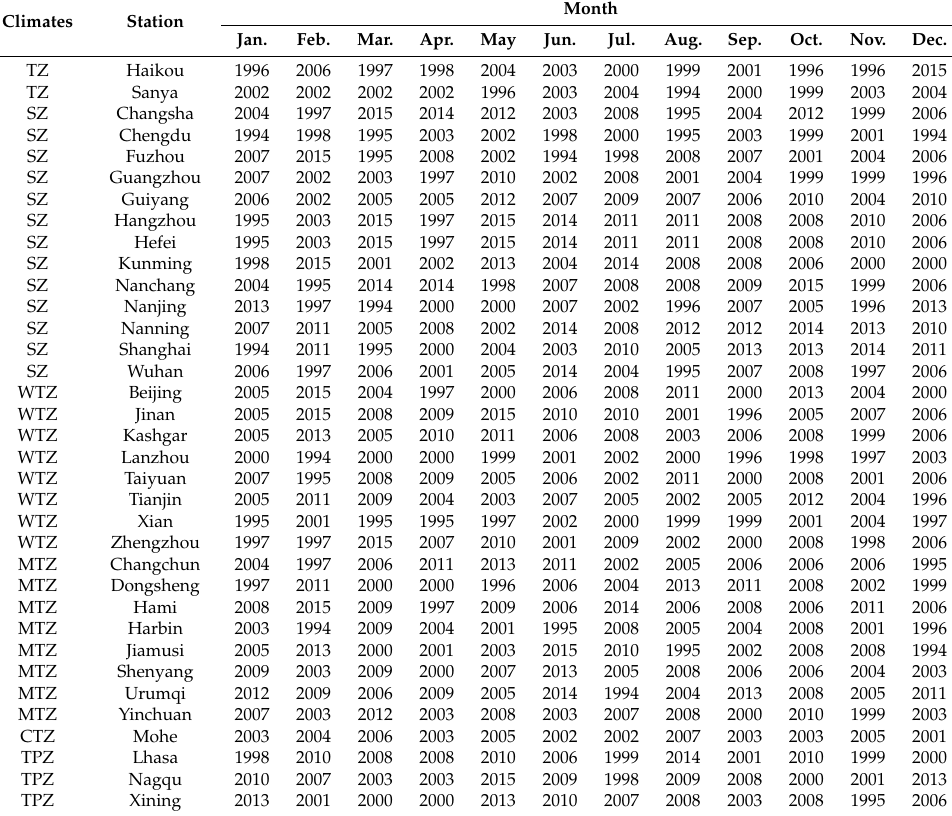
Table 5. The TMYs for the hybrid method of 35 cities in six different climatic zones of China.